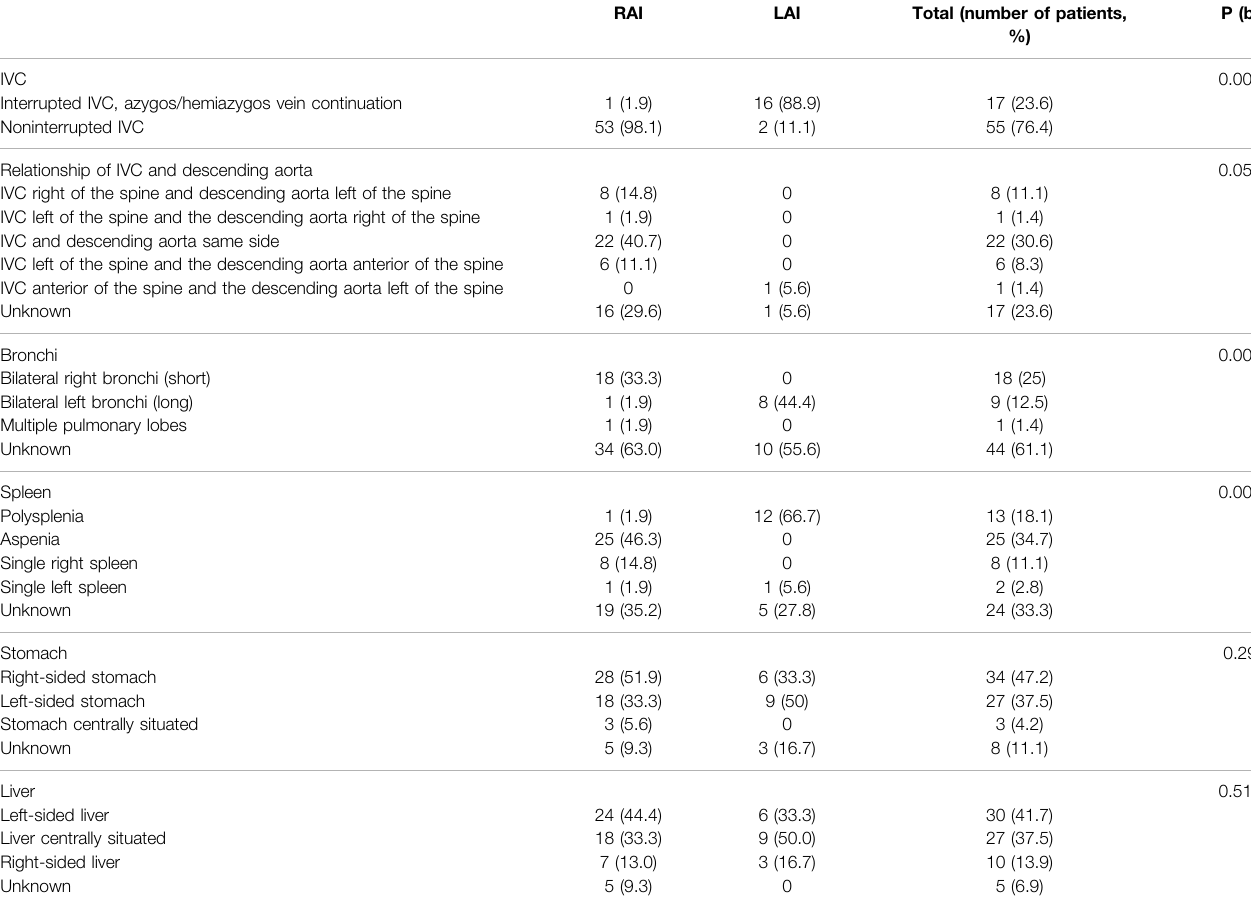
TABLE 2 | Spectrum of visceral abnormalities in right and left atrial